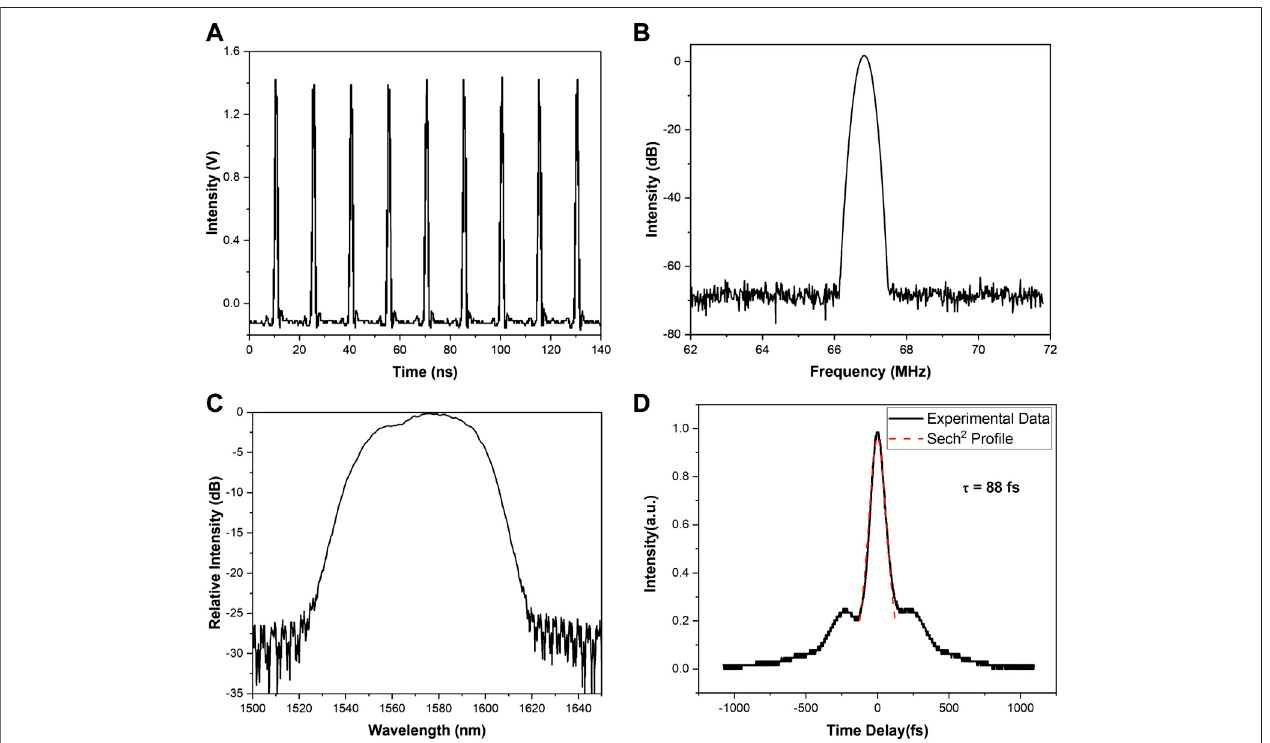
FIGURE 2 | Output of the fi ber laser when the mode-locked mechanism is self-started: (A) . pulse trains, (B) . rf spectrum with the fundamental rate. The resolution bandwidth (RBW) of the rf spectrum is 300 kHz. (C) Optical spectrum. The RBW of the optical spectrum is 0.15 nm. (D) The autocorrelation trace of ampli fi ed pulses before coupled into the HNLF. The trace center is fi tted with sech 2 function, showing a full width half maximum (FWHM) pulse width of 88